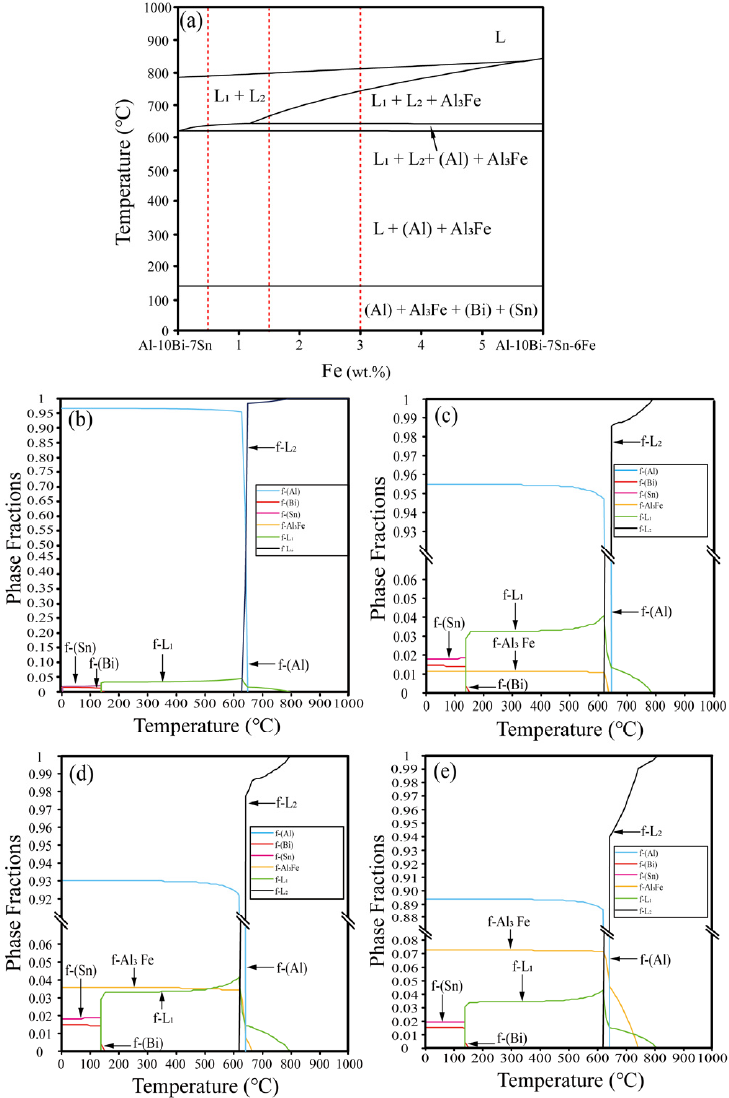
Figure 2. ( a ) Calculated vertical section diagram of Al-10Bi-7Sn-(0~6)Fe (wt.%) quasi-binary system and the phase fractions during solidification in ( b ) Al-10Bi-7Sn (wt.%) [33]; ( c ) Al-10Bi-7Sn-0.5Fe (wt.%); ( d ) Al-10Bi-7Sn-1.5Fe (wt.%); ( e ) Al-10Bi-7Sn-3Fe (wt.%). The SEM image of the cross-section morphology and the EDS elemental mapping of the Al-10Bi-7Sn-xFe (x = 0, 0.5, 1.5, 3) (wt.%) composite powders’ internal structure